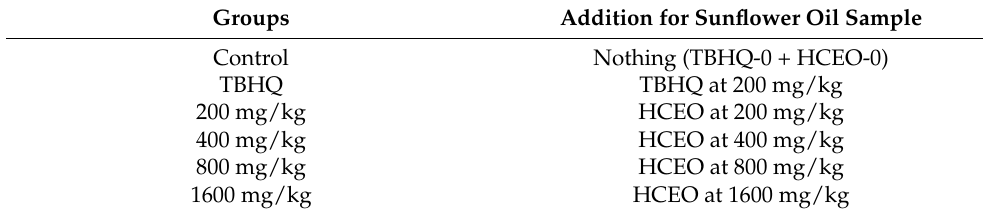
Table 1. The preparation of sunflower oil samples flavored by HCEO.